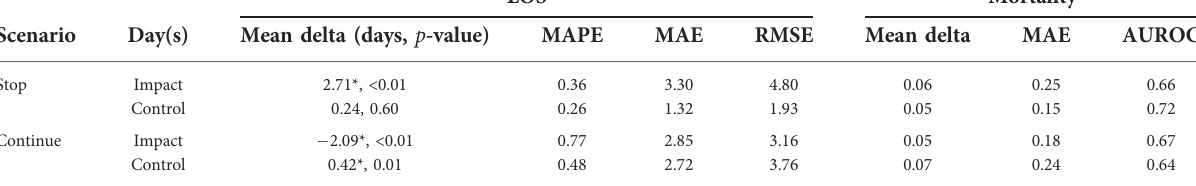
*Statistical signi fi cance with alpha set at 0.05. LOS, length of stay; MAPE, mean absolute percentage error; MAE, mean absolute error; RMSE, root mean squared error; AUROC, Area Under the Receiver Operating Characteristic curve.